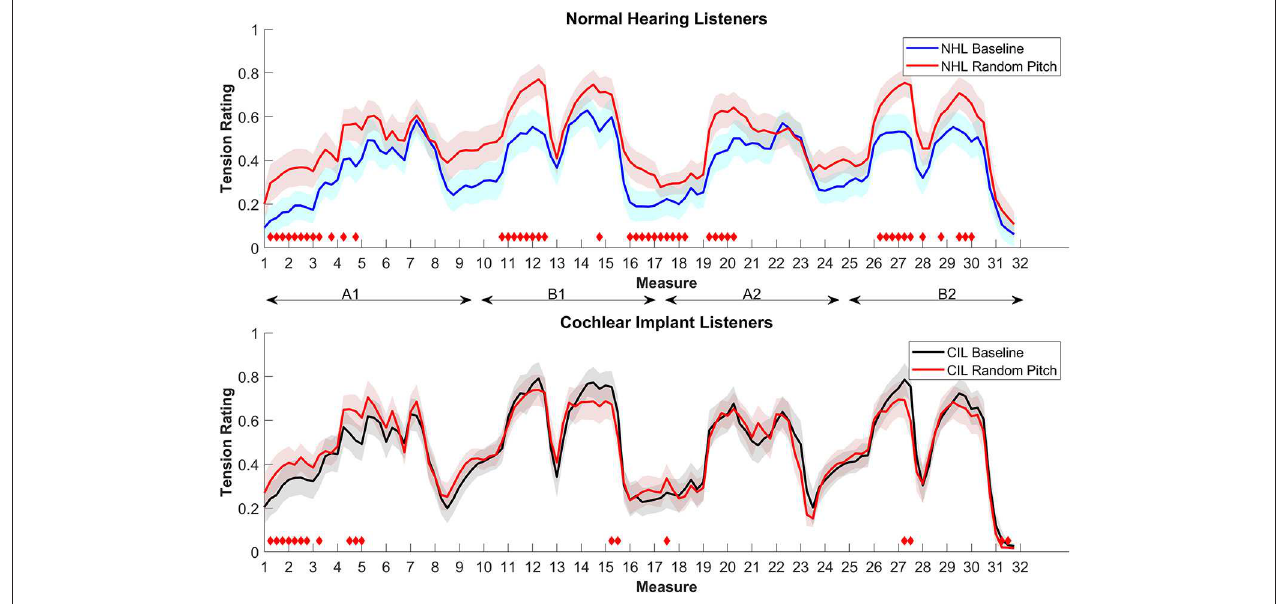
FIGURE 2 | Average tension ratings of 9 NHL (top panel) and 8 CIL (bottom panel) for the baseline and condition 2, random pitch (in red). See details in Figure 1 .